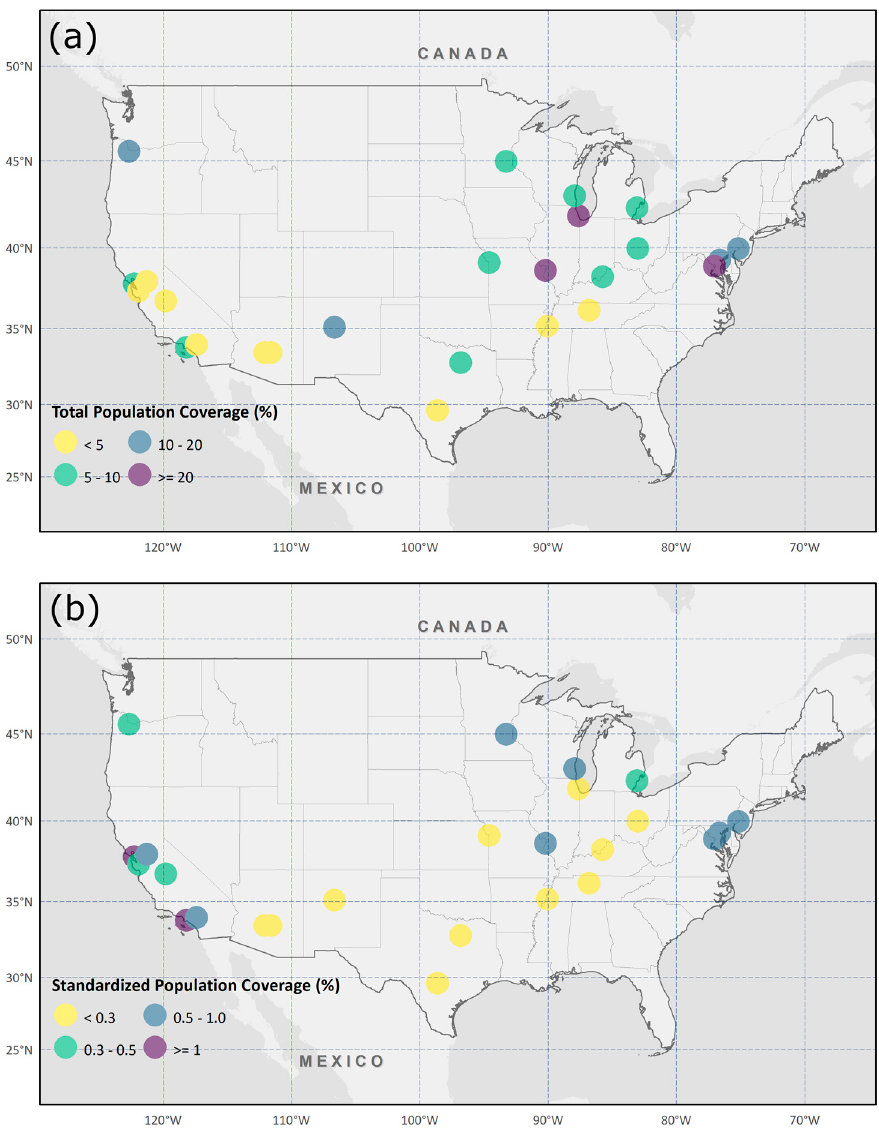
Figure 3. TPCs and SPCs of twenty-five study areas. ( a ) The spatial distribution of TPCs and ( b ) the spatial distribution of SPCs.